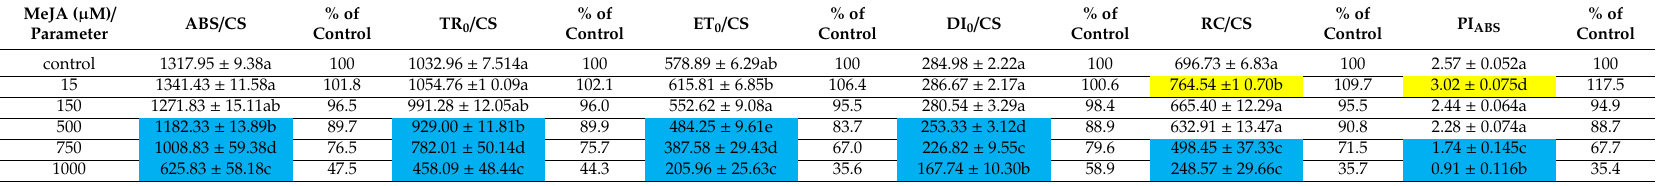
Table 1. Selected parameters related to photosynthesis e ffi ciency measured in leaves of barley seedlings after MeJA treatment. Means ± for the SE are presented for each of the analysed parameters. Statistical analyses were performed using a two-way ANOVA ( p < 0.05) followed by the Fisher Least Significant Di ff erence (LSD) test ( p < 0.05) to assess the di ff erences between di ff erent concentrations of MeJA. Statistically significant di ff erences ( p < 0.05) are indicated by di ff erent letters (a–d). A decrease of a parameter value in relation to the control is indicated in blue and an increase in yellow. ABS / CS, absorption energy flux per cross-section (CS) of leaf area; TR 0 / CS, trapped energy flux per CS; ET 0 / CS, electron transport flux per CS; DI 0 / CS, dissipation energy flux per CS; RC / CS, number of active reaction centres per illuminated CS; PI ABS , performance index on absorption basis (based on